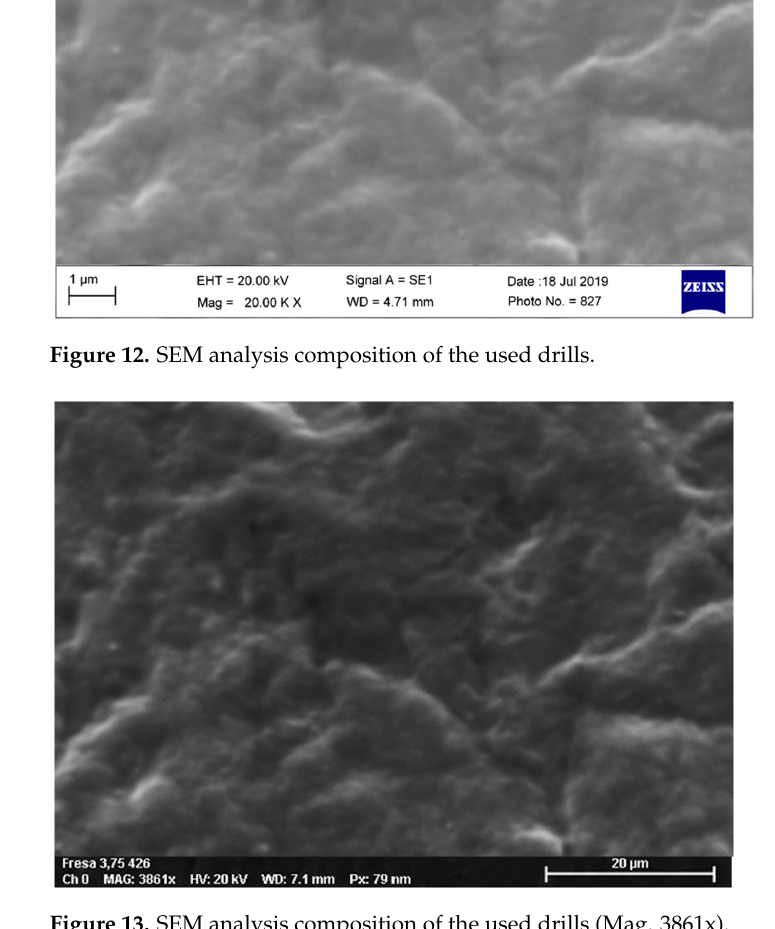
Figure 15. EDS ‐ SEM analysis composition of the non ‐ used tappers . 4. Discussion It is well known that the amount of osteotomies and the disinfection/sterilization pro ‐ cedures play a key role in drill cutting efficiency and bone heating, with significant clinical relevance [5,14]. Bone necrosis caused by excessive surgical trauma could affect the opti ‐ mal healing and it is one of the most common causes of excessive early bone resorption, which could impair the implant stability, facilitate bacterial infiltration and lead to peri ‐ implantitis induction [16]. The temperature increase is also correlated with bone density, and the drilling strength resistance, which depends on local bone composition, precisely by the cortical and spongious bone ratio [17–19]. A thicker cortical layer corresponds to a harder bone and a higher risk of generating high temperatures. Hence, the general advice is to use different protocols to create the implant site based on bone tissue density. These protocols envisage differences in terms of type and number of drills used and rotation velocity (number of revolutions per minute). It has been noticed that sharp drills, com ‐ bined with high rotation velocity, allow us to rapidly create the implant site, reducing the risk of heat build ‐ up [20–23]. On other hands, blunt drills find it more difficult to create a path, with a subsequently longer period of exposure to an increase in heat and a higher risk of bone necrosis [24]. A recent study assessed the changes in bone temperature during